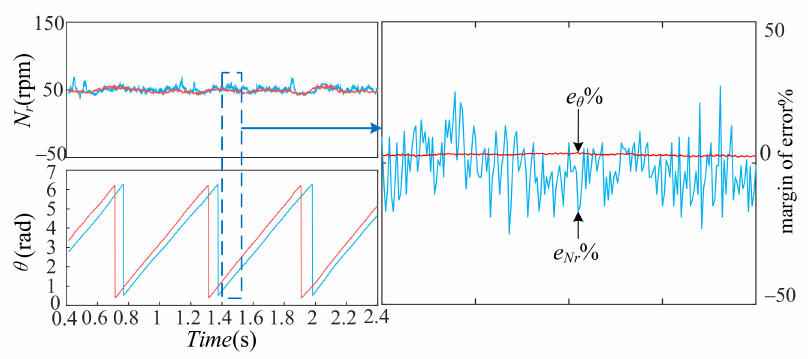
Figure 10. Tracking performances of speed and position under a speed command of 50 rpm (the red line represents the actual value, and the blue line represents the estimated value).